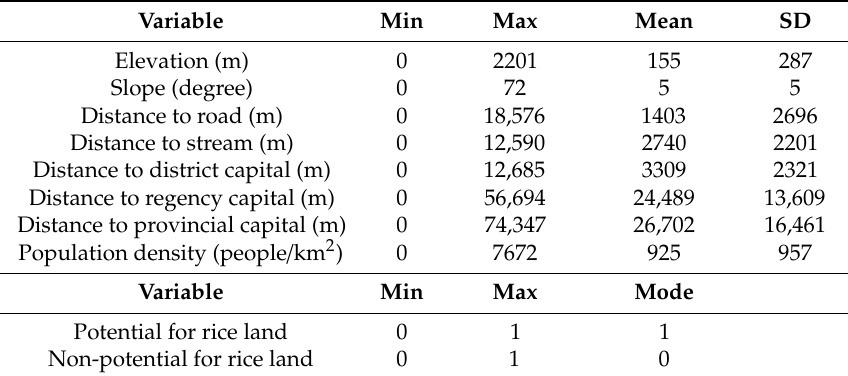
Table 7. Descriptive statistics of each biophysical variable.